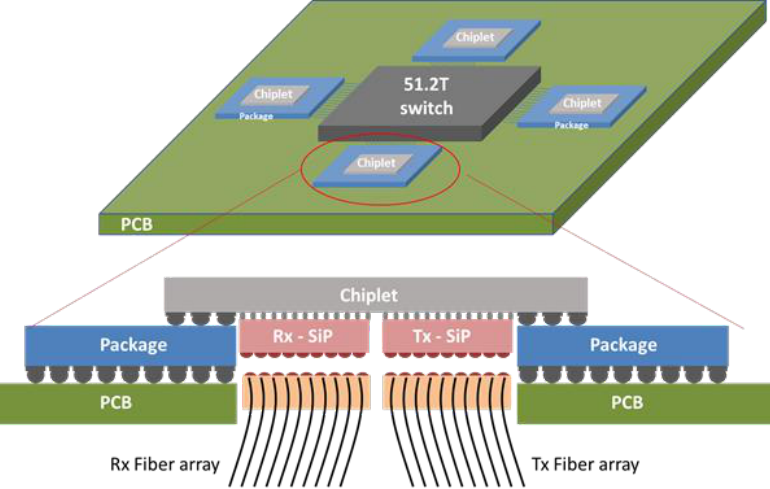
Figure 2. A schematic of the L3MATRIX Approach: Switch and I/O ASICs co-packaged on a common substrate. Inset: Side-view layout of the chiplet assembly with Tx and Rx SiP matrices; the chiplet is assembled facing down through a cutout hole in the